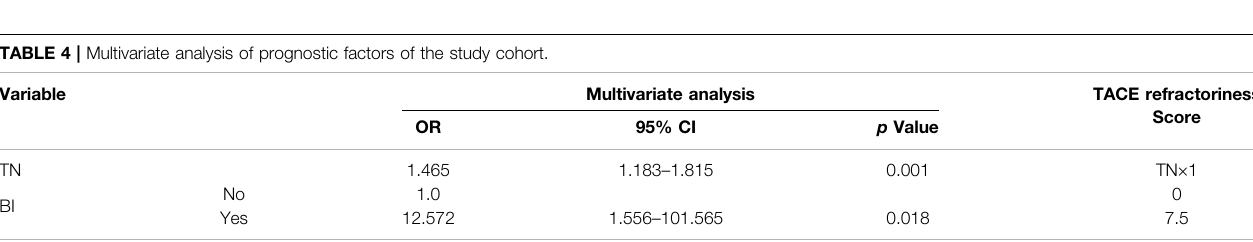
FIGURE 3 | Kaplan-Meier survival curves of the validation cohort. Green line: TACE-refractory group. Blue line: TACE-non-refractory group.